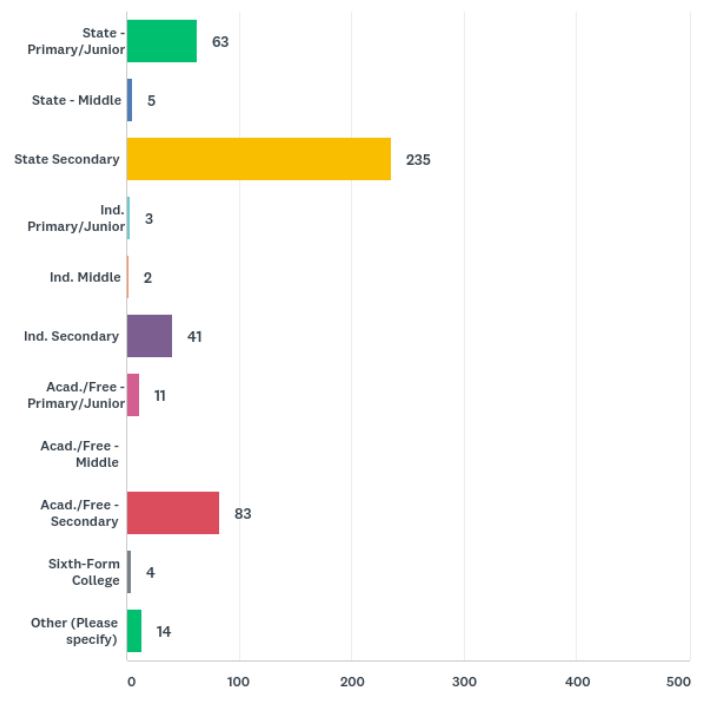
Figure 1. Question 4: Which school sector do you work in? ( N = 461).